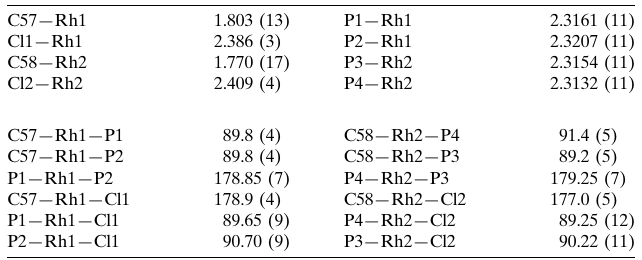
Selected geometric parameters (A˚ , (cid:2) ).